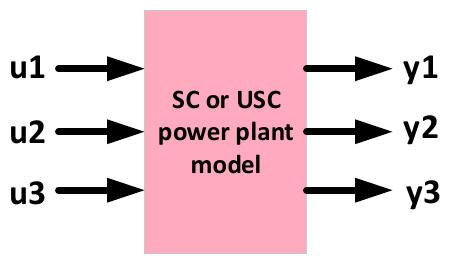
Figure 4. 3-input 3-output supercritical (SC) or ultra-supercritical (USC) model. The input vector U = [ u 1 u